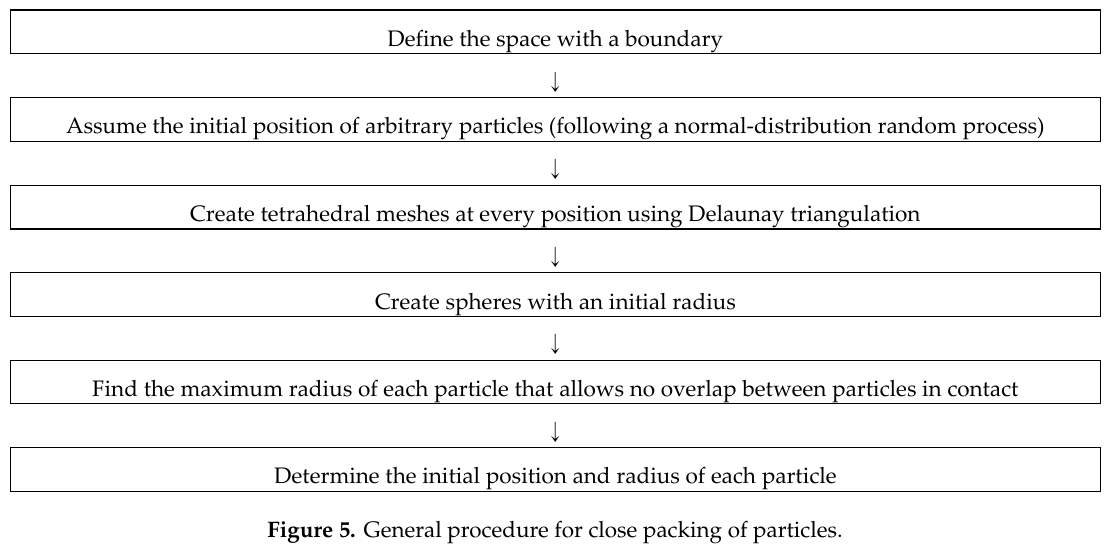
Figure 5. General procedure for close packing of particles.